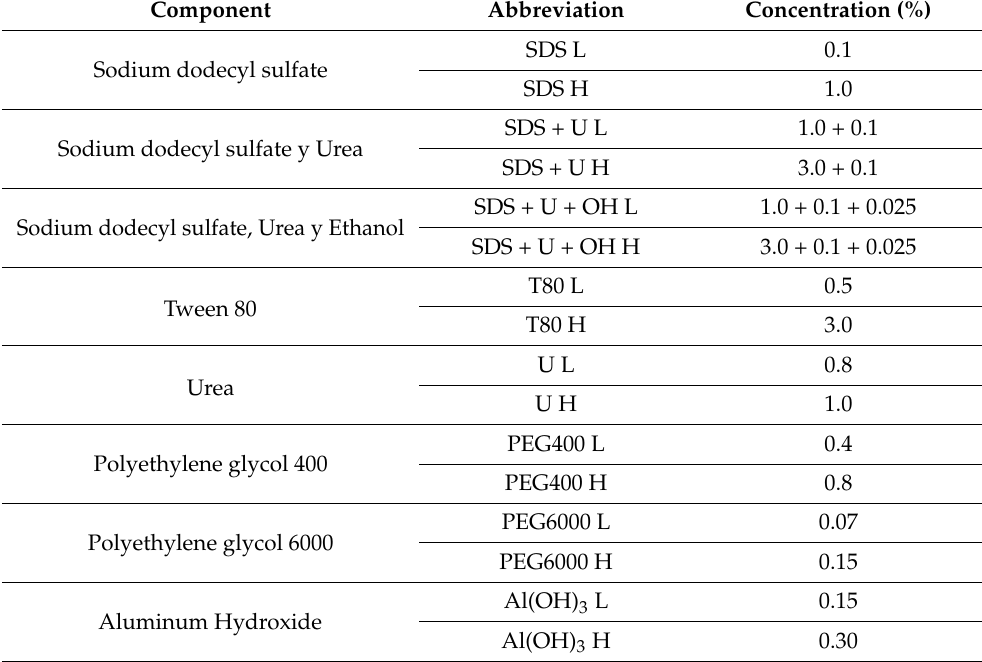
Table 2. Deproteinization